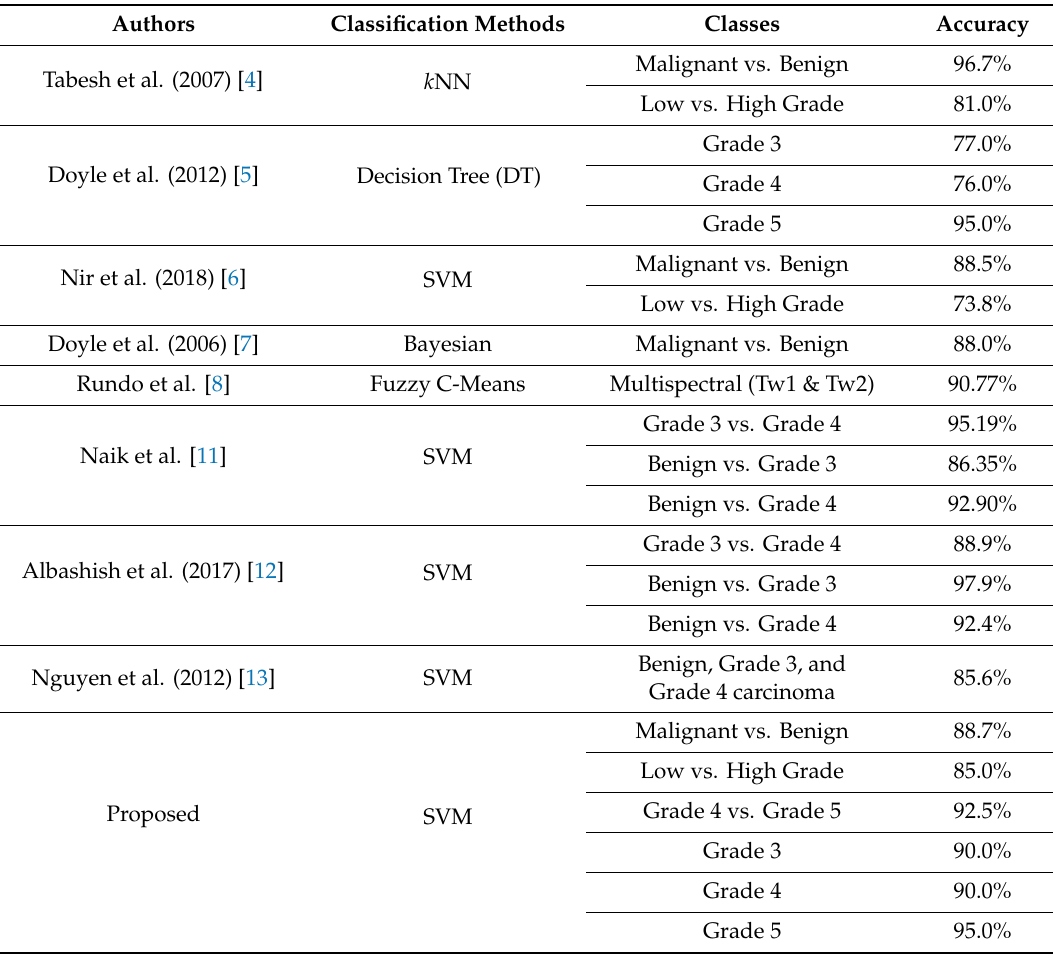
Table 9. Comparison between the proposed method and other standard methods for the classification of prostate cancer